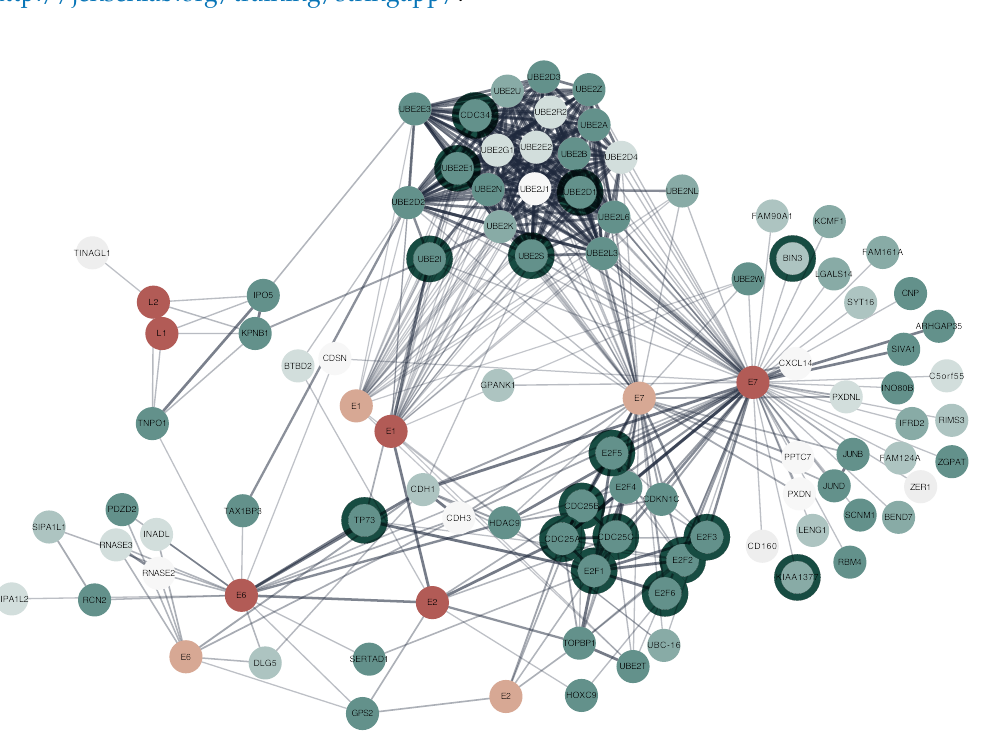
Figure 4. HPV and Homo sapiens interaction network in Cytoscape. Proteins from Human Papillomavirus type 16, and HPV type 1a with their human protein interaction partners. Virus proteins are coloured according to their species (dark red: HPV 16, light red: HPV 1a). The human proteins are coloured in shades of green with darker colours showing a stronger association with the nucleus. The dark halos around human proteins are those that are associated with the GO term for cell cycle. The HPV E6 and E7 proteins are known to interfere with the cell cycle. This analysis shows some of the data exploration and visualization flexibility that is easily possible within